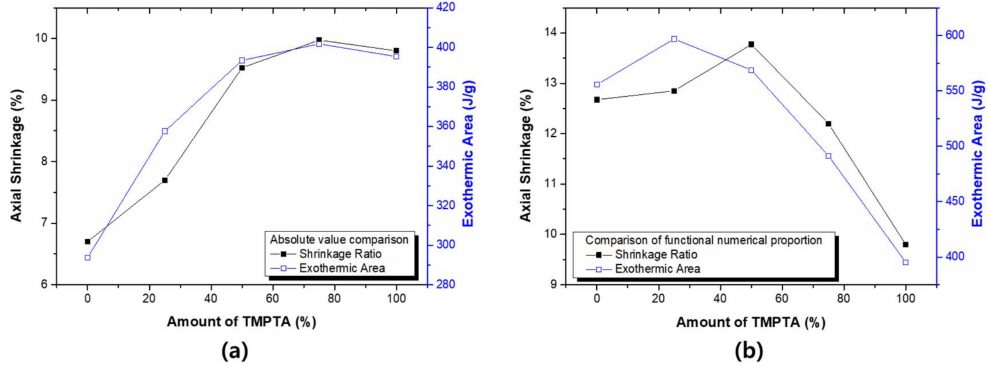
Figure 6. Comparative evaluation of the shrinkage ratio and the exothermic area: ( a ) comparison of the absolute value; and ( b ) comparison of the relative value based on acrylate ratio.